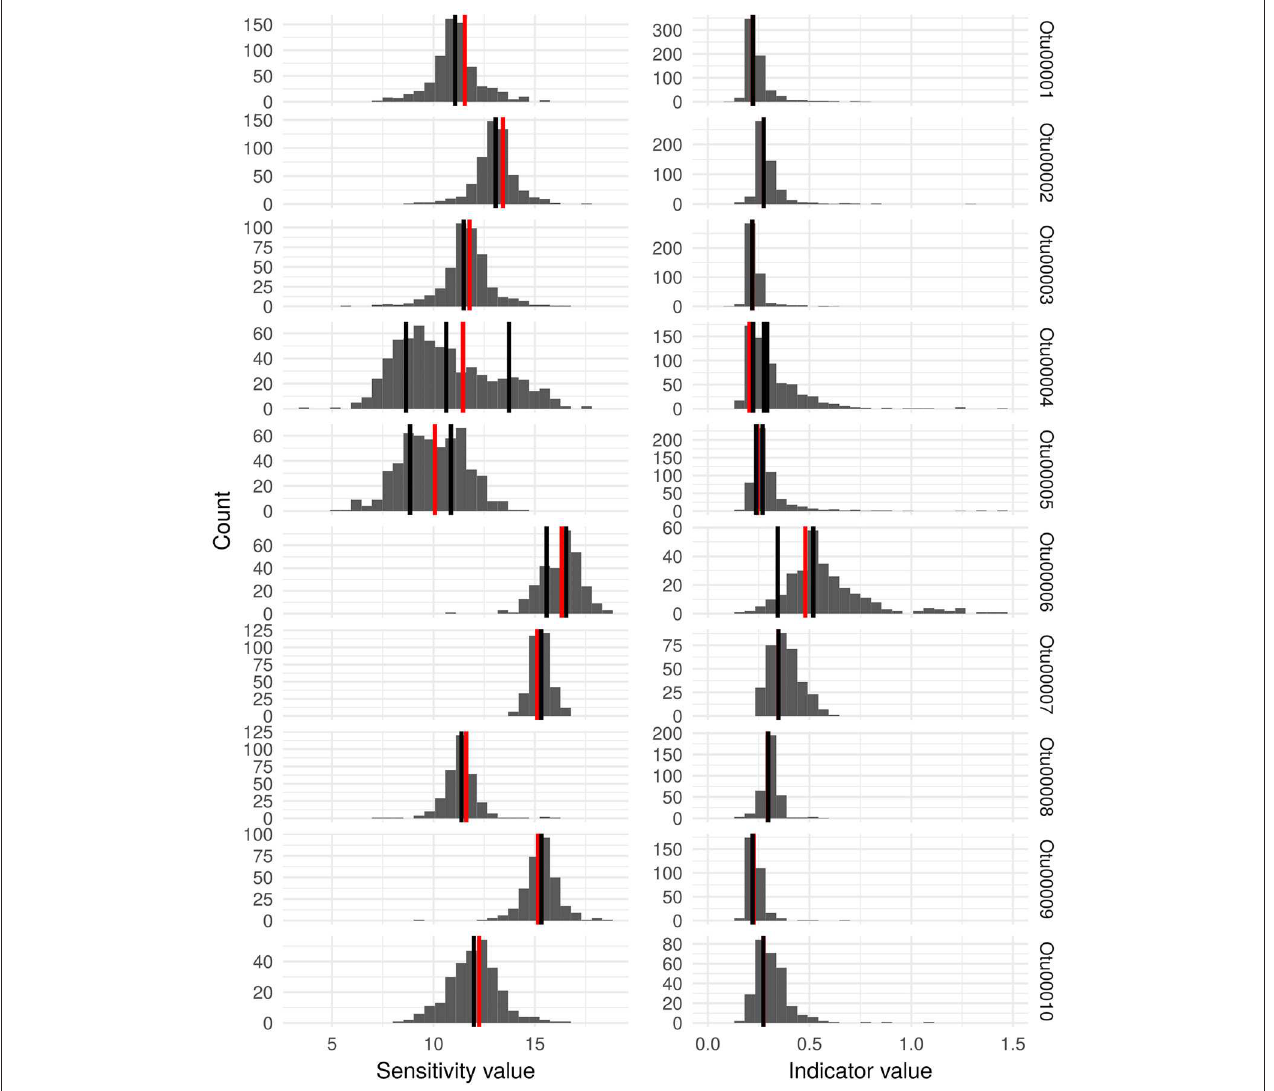
FIGURE 4 | Histograms representing the distribution of the estimated sensitivity values and indicator values in the Idx_ISU for the ISU that were clustered into the 10 most abundant OTU. For each OTU, the vertical black lines indicate the ecological values of the most abundant ISU (relative abundance in the entire dataset > 0.1%) and the vertical red line shows the ecological values estimated for the complete OTU